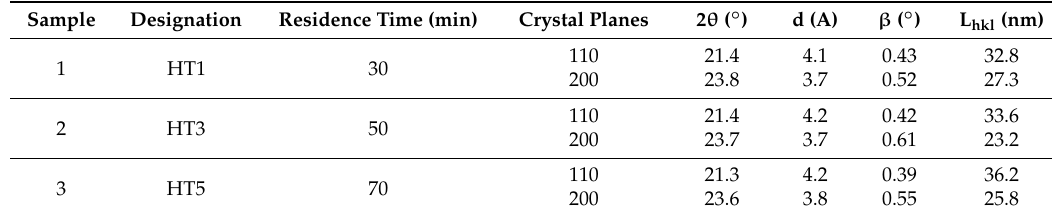
Figure 22. X-ray diffraction pattern for HDPE/TiO 2 nanocomposites fabricated at various residence times. Table 8. Summary of the parameters retrieved from the XRD curves.